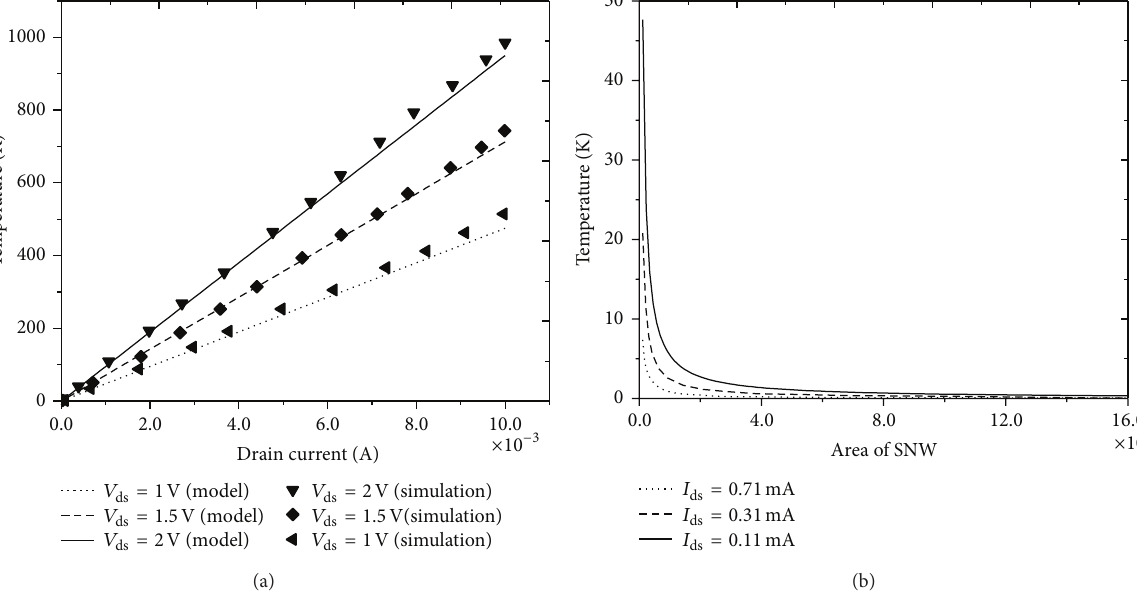
Figure 6: (a) Characteristic of temperature versus drain current. (b) Characteristic of temperature versus area of